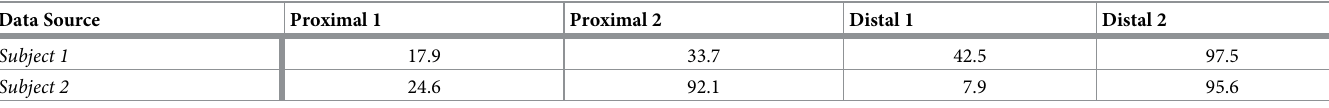
Table 2. Percentage of PGD > 0.5 for inverse results on human recording and region.